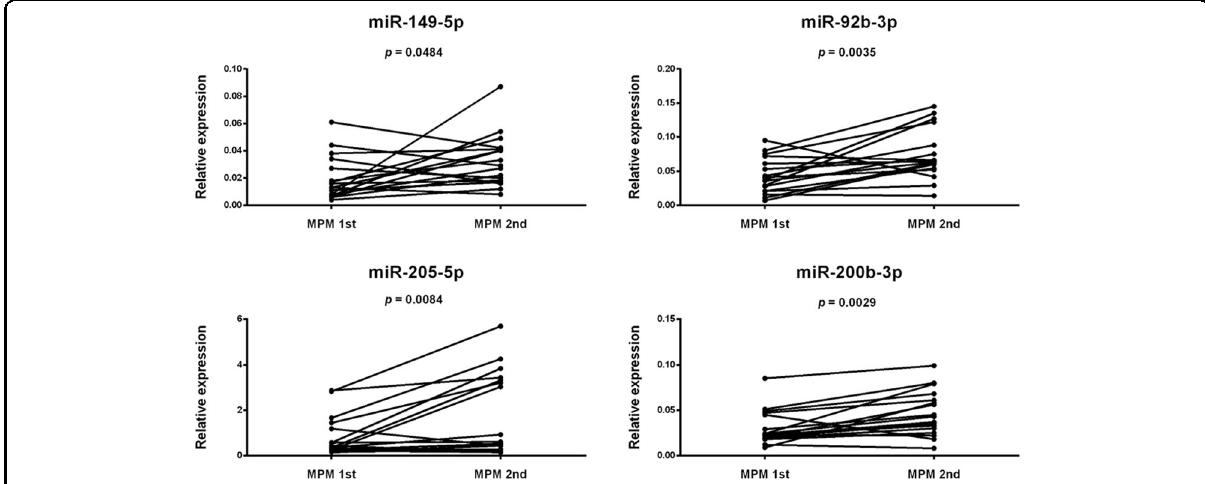
Fig. 3 Differential microRNA expression in fi rst vs. second melanoma from the same patient. Before – after plot showing the paired expression of 4 selected microRNAs in 17 multiple primary melanoma (MPM) patients. miR-92b-3p, miR-205-5p, miR-200b-5p, and miR-149-5p are signi fi cantly downregulated in the fi rst melanoma compared to the second melanoma. Each miRNA was tested in triplicate by quantitative RT-PCR. Relative miRNA expression was normalized on invariant miR-16-5p. Paired t-test p -value is reported.